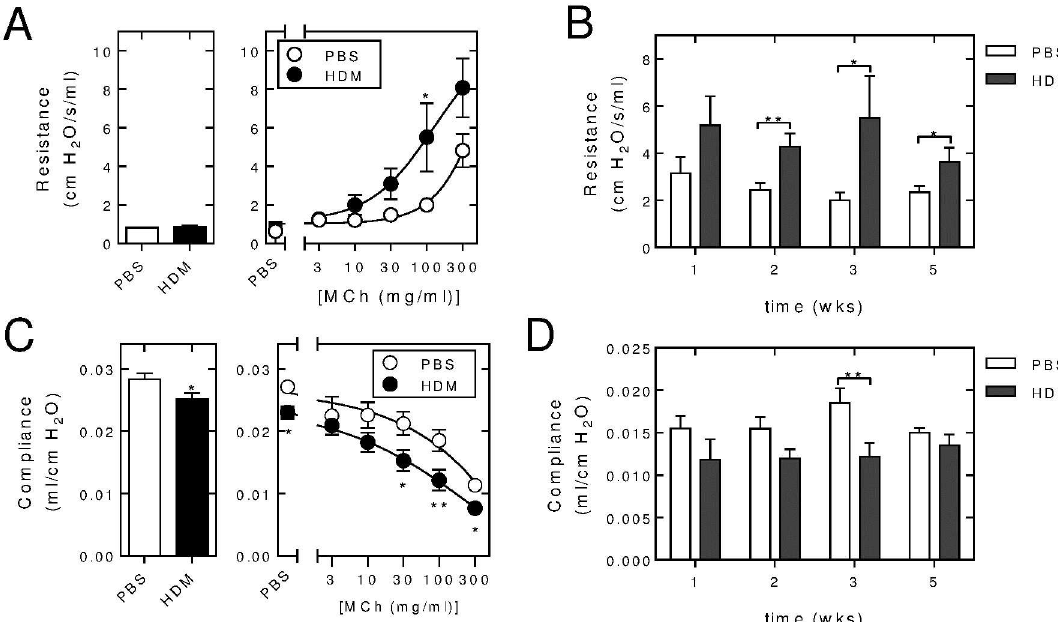
Fig 1. Effect of i . n . HDM instillation on lung function. A & C, Wild type C57/Bl6mice were subjectedto i . n . instillationof PBS or HDM (25 μ g) 3 times/week for 3 weeks after which lung function was measuredusing a Flexivent apparatus. Airways resistance(cm H 2 0/s/ml) and compliance(ml/cm H 2 O) are shown at base line (left panels) and followinginhaledchallenge with PBS or increasing concentrations of methacholine(MCh) as indicated.Data ( N = 6 for PBS- and 8 for HDM-exposed groups) are plotted as means ± SE. B & D, Wild type C57/Bl6mice were subjectedto i . n . exposurewith PBS or HDM (25 μ g) 3 times/week for the indicatednumber of weeks prior to lung function analysis. Resistance and compliance( N = 4–12) followingMCh (100 mg/ml) challengeare plotted as means ± SE. Significance was tested betweenPBS and HDM treatments by unpairedMann Whitney U test. * P < 0.05, ** P < 0.01.